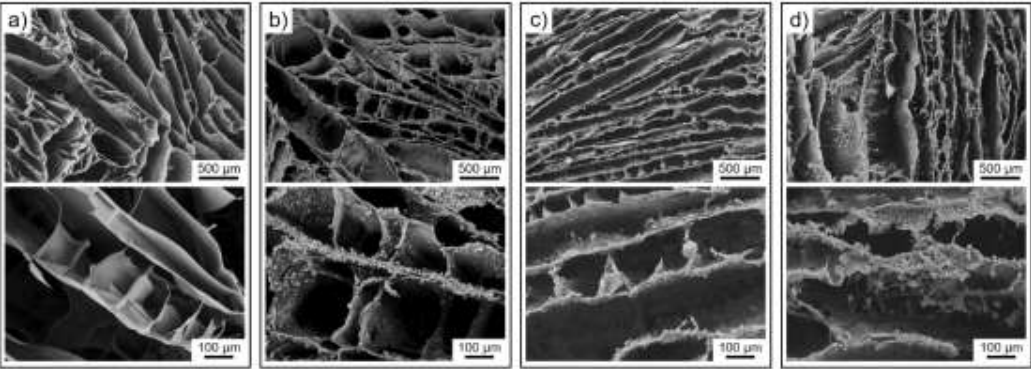
Figure 3. SEM micrographs showing the cross-section of ( a ) pristine CS and ( b – d ) hybrid CS/LTA aerogels at different weight ratios: ( b ) 2:1, ( c ) 1:1, and ( d ) 1:2.